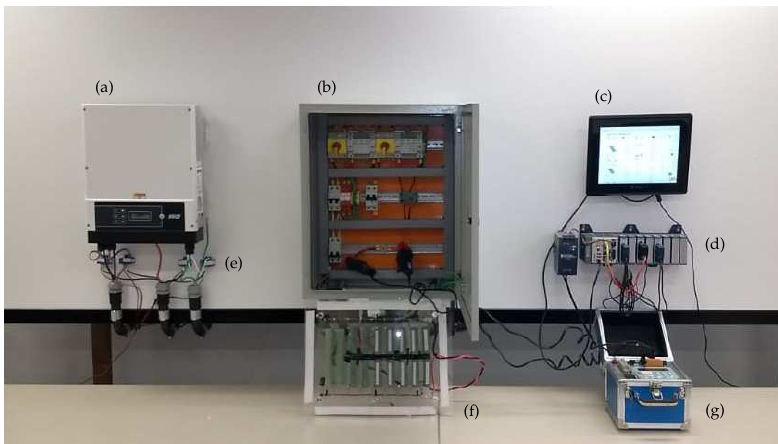
Figure 1: The proposed method consists in transmitting a frame using ⌈ α n cha ⌉ channel uses for the fi rst trans- mission attempt, with 0 < α ≤ 1 . In the event of a decoding error, incremental redundancy is transmitted 1 − α n cha ⌋ channel uses. making use of the rest of the available ⌊ ( )